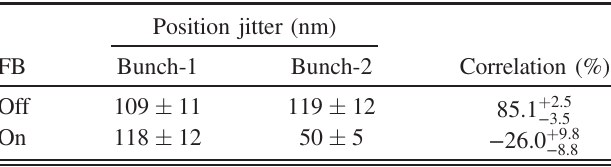
TABLE IV. Position jitters and bunch-to-bunch position corre- lation with feedback off and on, for single-BPM feedback.